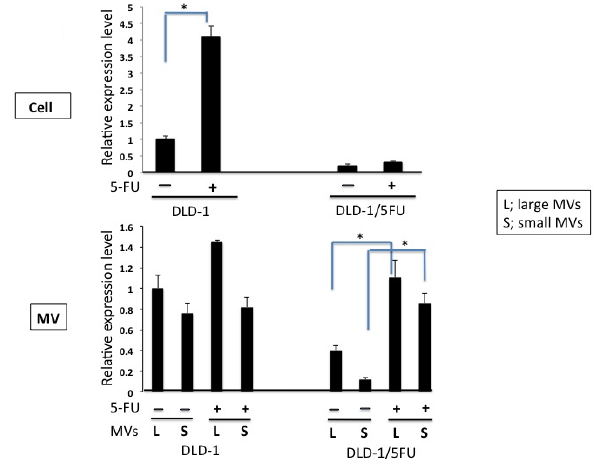
Figure 4. Detection of miR-34a levels in DLD-1 and DLD-1/5FU cells and in their MVs. Levels of miR-34a in the cells and in the MVs trapped by the two filters of the ExoMir kit. The upper panel shows the relative expression of miRNAs before and after the treatment with 5-FU (10 µM) for 48 h, with the quantities given being relative to the amount in DLD-1 cells indicated as “1”. Lower panel shows the relative expression of the miRNAs in MVs from DLD-1 and DLD-1/5FU cells before and after the treatment with 5-FU (10 µM) for 48 h. The results are presented at the average value of three independent experiments. “+”: treatment with 5-FU; “ − ”: treatment with DMSO alone.* p < 0.05 is considered to be